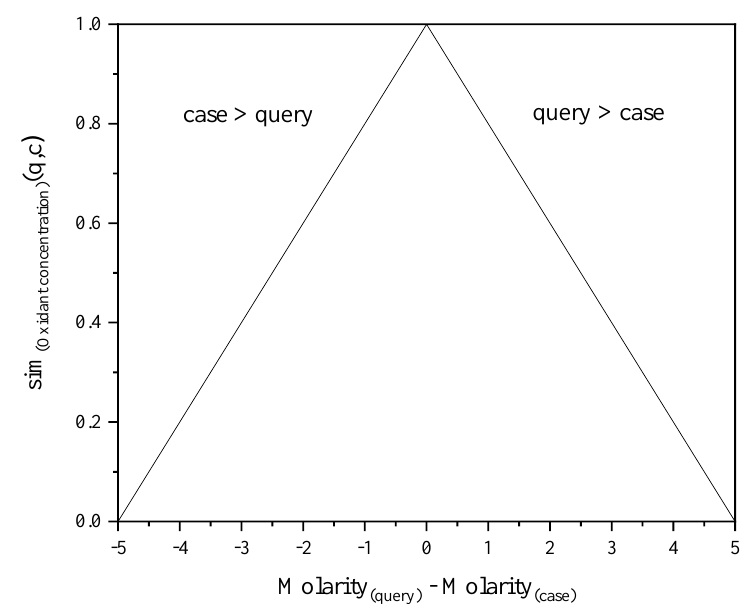
Figure 2. An example of a possible linear distance function for Oxidant concentration .